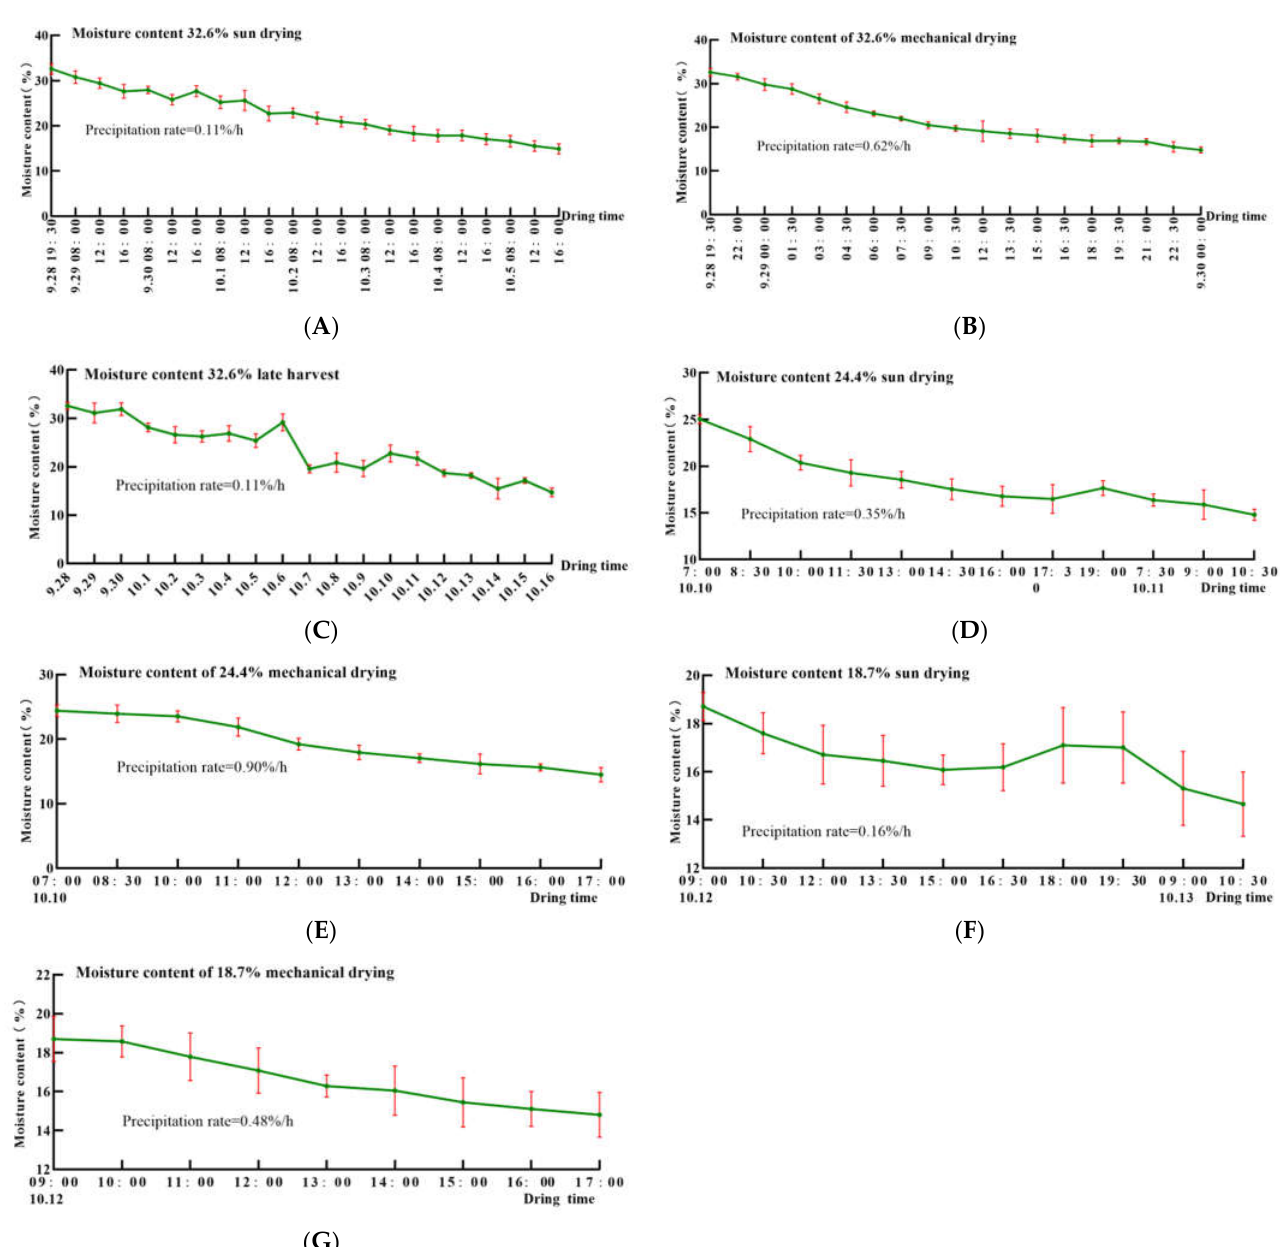
Figure 2. Paddy moisture content change during different drying methods: ( A ) 32.6% sun drying, ( B ) 32.6% mechanical drying, ( C ) 32.6% late harvest, ( D ) 24.4% sun drying, ( E ) 24.4% mechanical drying, ( F ) 18.7% sun drying, ( G ) 18.7% mechanical drying.